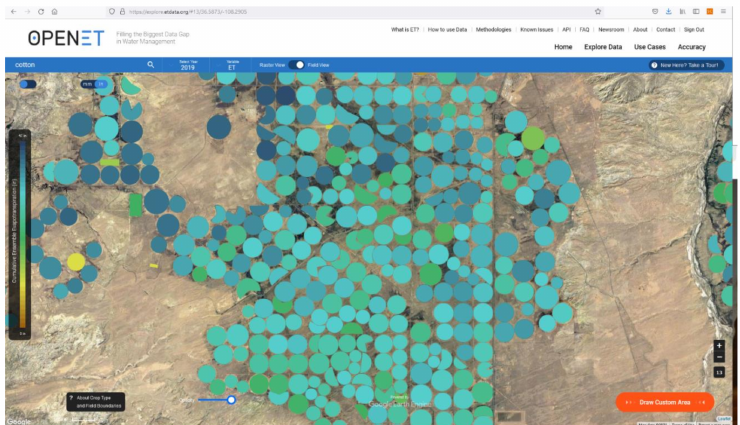
Figure 4. The OpenET Data Explorer showing the fields across the Region 2 mostly dedicated to potato production of the Navajo Agricultural Products Industry